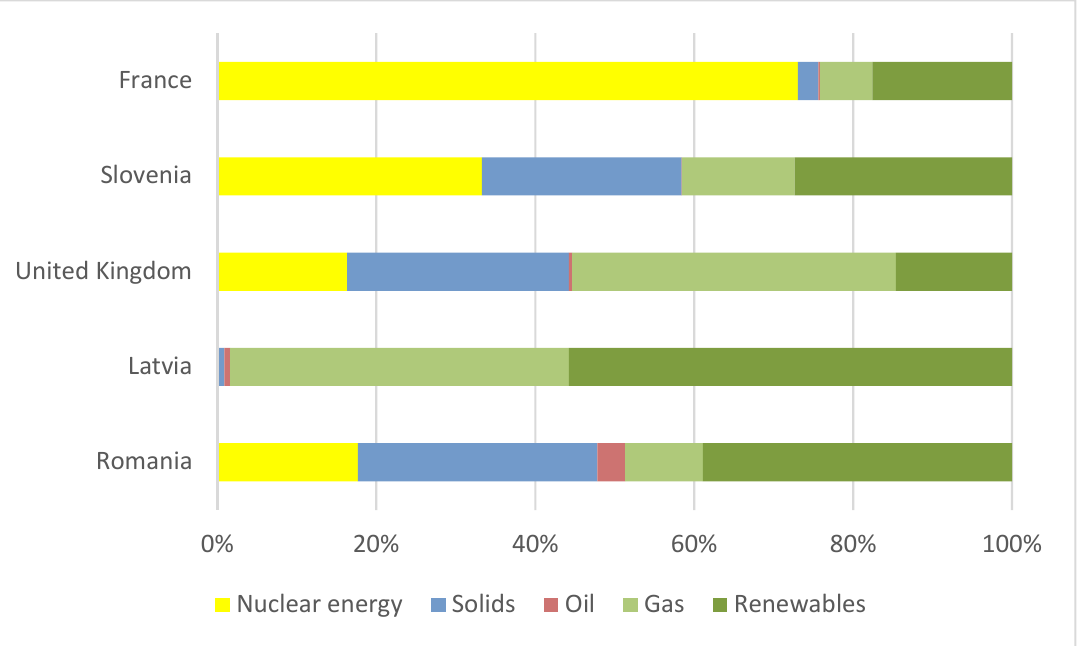
Figure 8. Structure of energy mixes for the third cluster . Source (own elaboration).